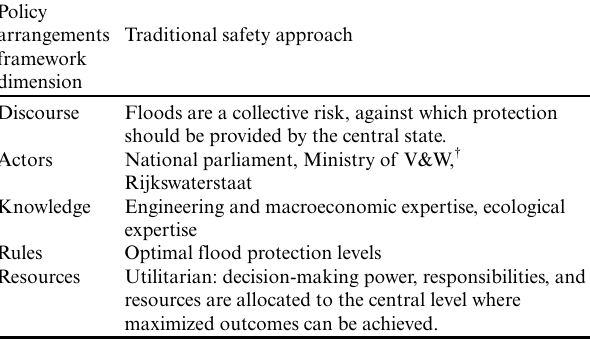
Table 1 . The policy arrangement underlying the Dutch safety